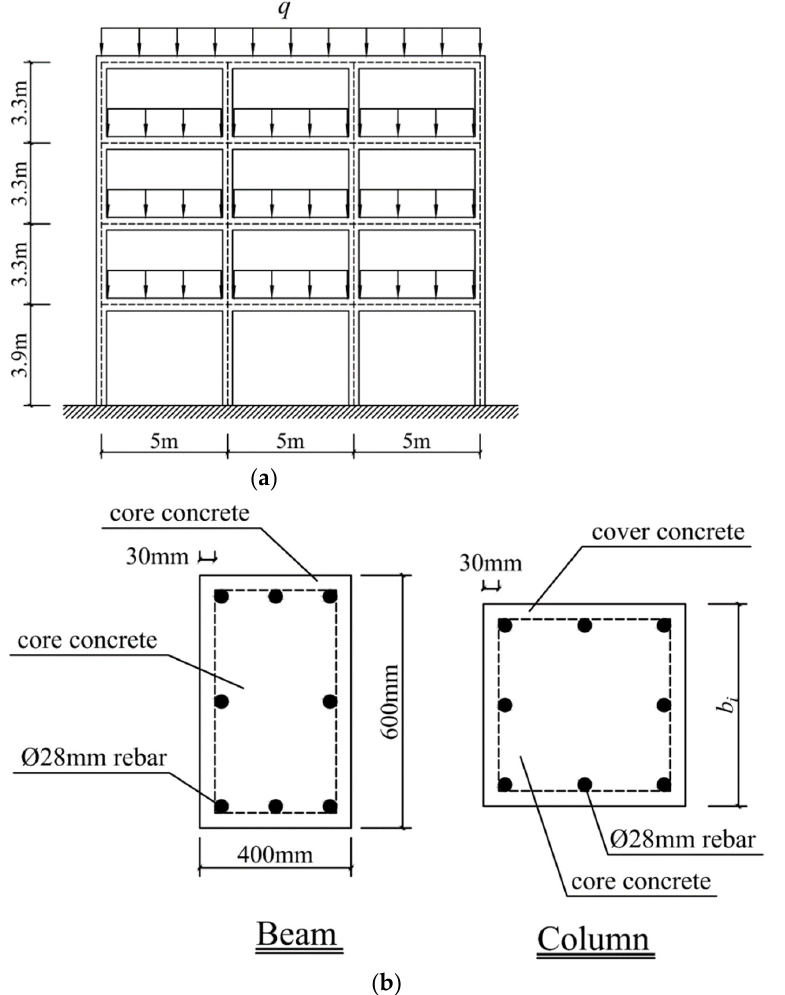
Figure 8. Three-storey reinforced concrete frame. ( a ) Schematic. ( b ) Cross sections.